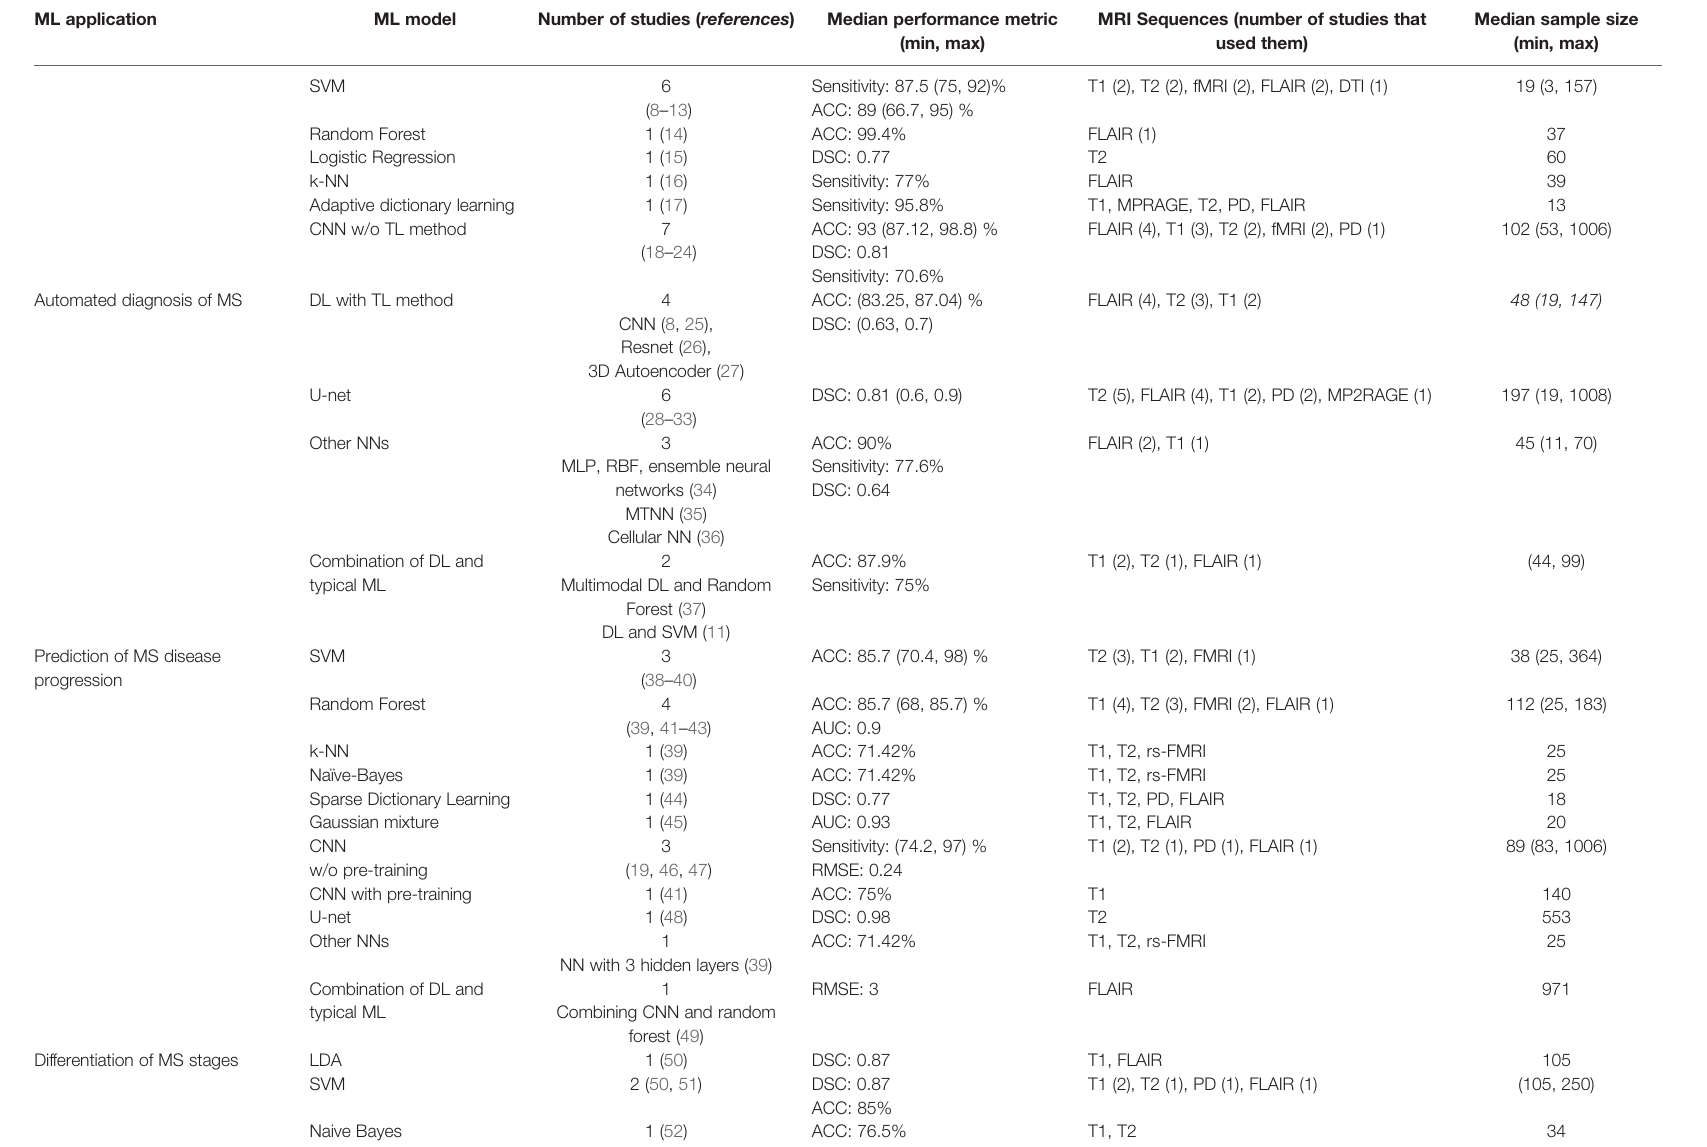
TABLE 1 | 54 publications were grouped into 4 categories based on the application of ML Learning in MS